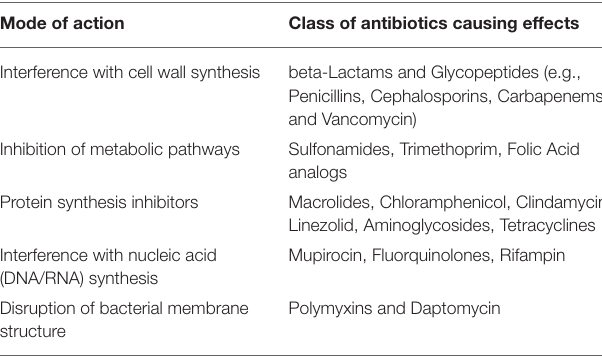
TABLE 2 | Mechanism of action for antibiotics in causing microbial resistance (modified after Romero et al.,